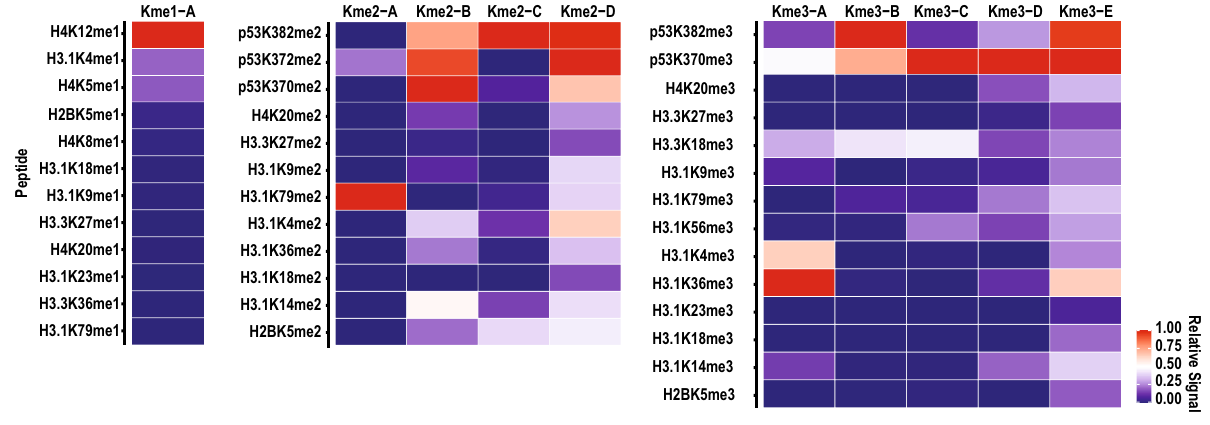
Figure 1. Analysis of pan-methyllysine antibodies by peptide microarrays. Heatmaps depict the average fluorescent signal intensity (n = 9) from a histone peptide microarray hybridized with a pan-methyllysine antibody. Data is normalized to the highest signal in each column on the microarray and the color code is proportional to the fluorescent signal, where red (1) indicates more antibody hybridization and blue (0) indicates less antibody hybridization. Rows show the identity of each histone peptide and columns show the pan-methyllysine antibody